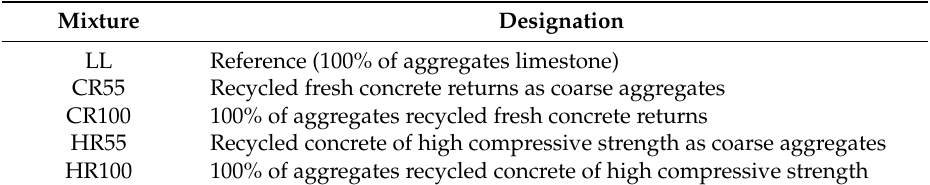
Table 1. Terminology for all concrete mixtures.